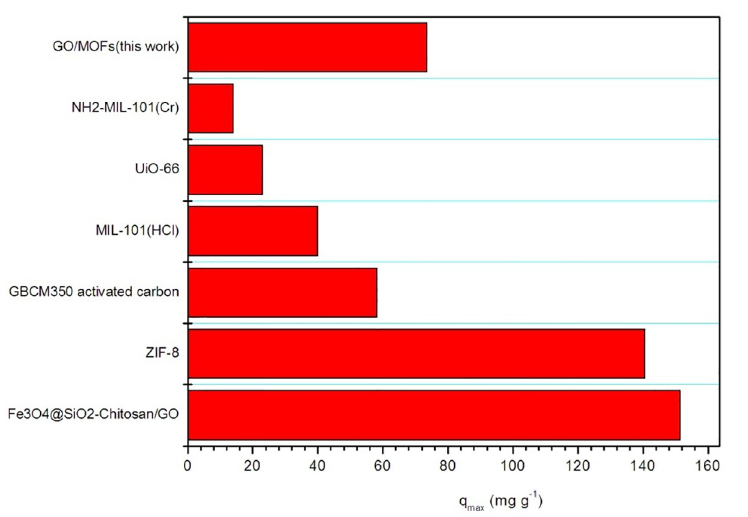
Fig 5. Comparison of the GO/MOFs adsorbent with other materials on TC adsorption.